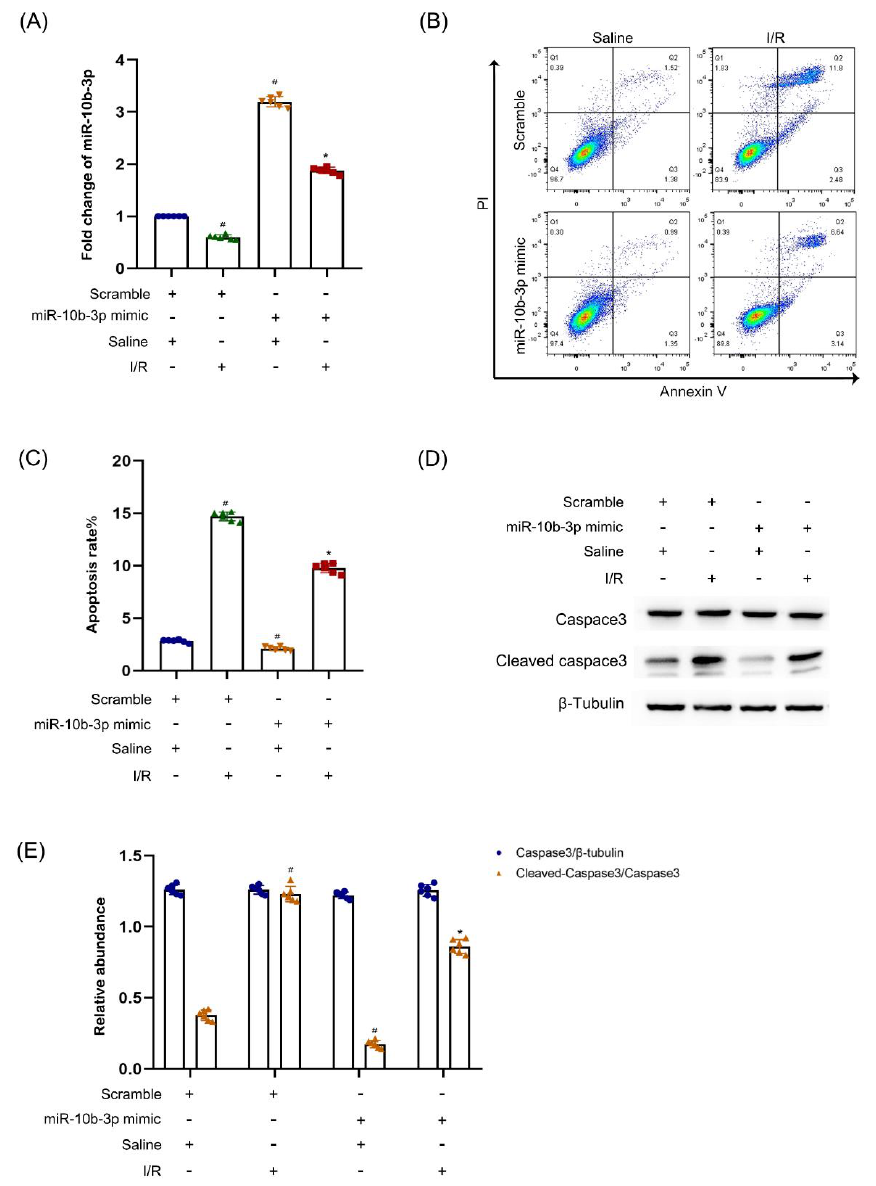
Figure 5. Overexpression of miRNA − 10b − 3p attenuated I/R-induced the apoptosis and the expression of cleaved − caspase 3 in BUMPT cells. BUMPT cells were transfected with 100 nM miRNA−10b−3p mimics or scramble, and then treated with or without I(2 h)/R(2 h) injury. ( A ) The RT − qPCR analysis of the expression of miRNA − 10b − 3p. ( B ) FCM analysis of apoptosis in BUMPT cells. ( C ) Apoptosis rate (%). ( D ) The immunoblot analysis of the expression of caspase 3 and cleaved-caspase 3. ( E ) The gray analysis between them. Data are expressed as mean ± SD ( n = 6). # p < 0.05, I/R with scramble group vs. scramble group; * p < 0.05 vs. I/R with scramble